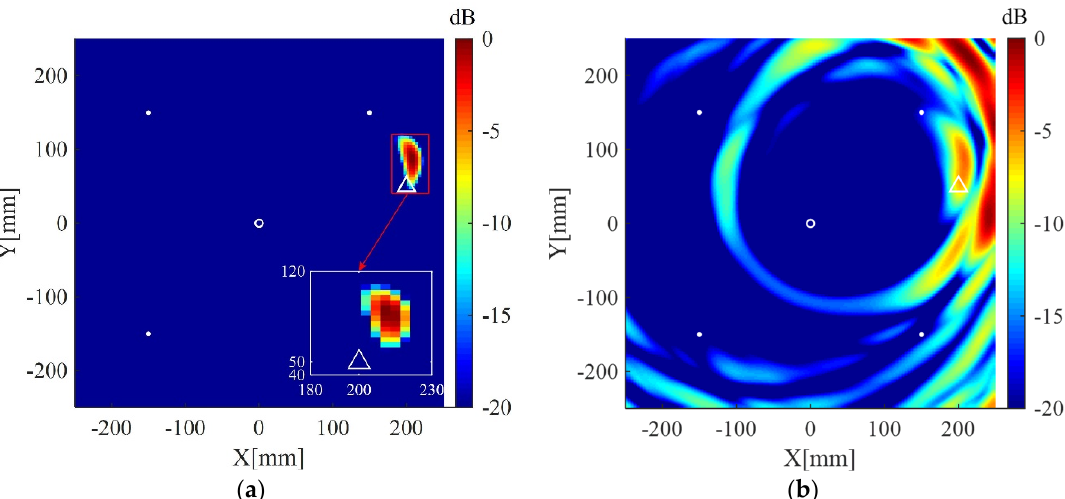
Figure 5. Imaging results in simulation II using: ( a ) the weighted structured sparse reconstruction-based Lamb wave imaging method (the location error is 34 mm); ( b ) the delay-and-sum imaging method (the location error is 179 mm). White dots denote locations of measuring points, the white circle denotes the location of excitation source, and the white triangle denotes the center of the crack II.